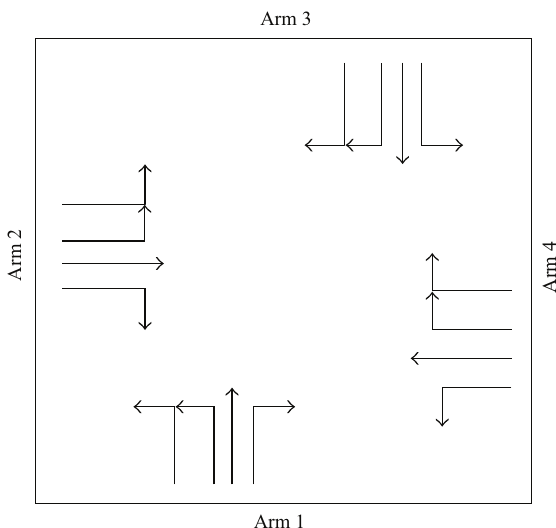
Figure 3: Optimized lane markings for the example problem.